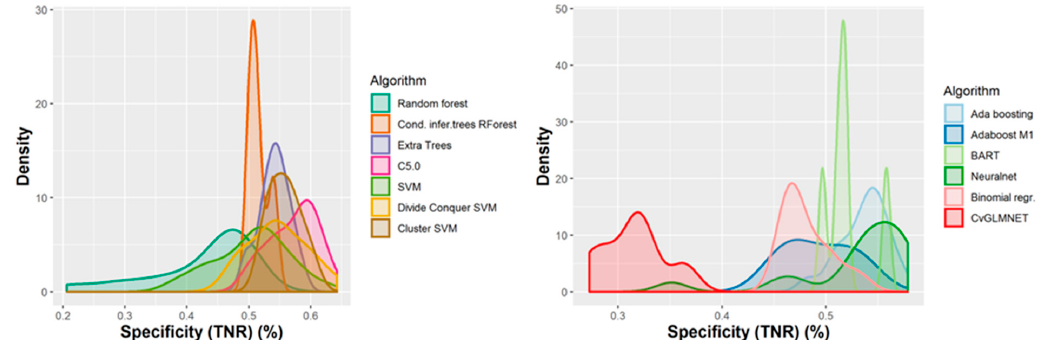
Figure 4. Performance of 165 QSAR models in terms of specificity.